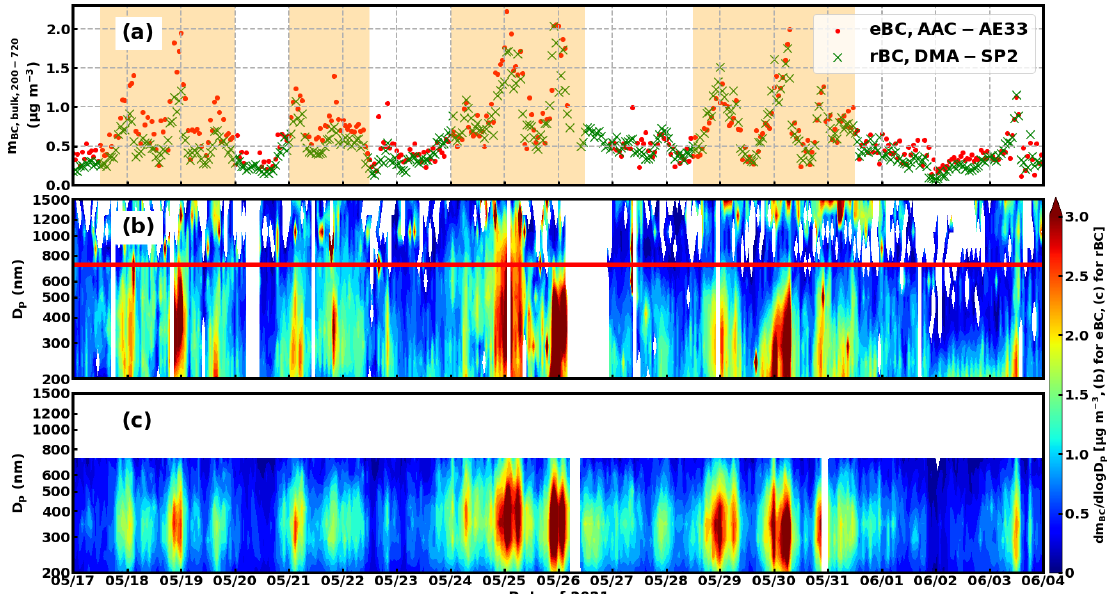
Figure 2. Time series of (a) m BC , bulk from BCMSD integrated from 200 to 720nm ( m BC , bulk , 200 − 720 ) determined by the proposed method (red dot, denoted as “eBC, AAC–AE33”) and the DMA–SP2 (green cross, denoted as “rBC, DMA–SP2”) and BCMSD determined by (b) the proposed method (eBC) and (c) the DMA–SP2 (rBC). The red line in panel (b) marks a particle size of 720nm. The pollution episodes are shaded with orange in panel (a) .